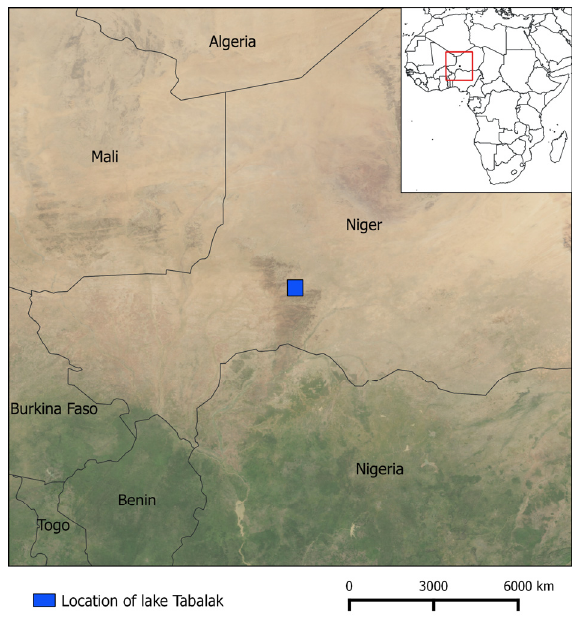
Figure 1. The study area Lake Tabalak, Niger, West